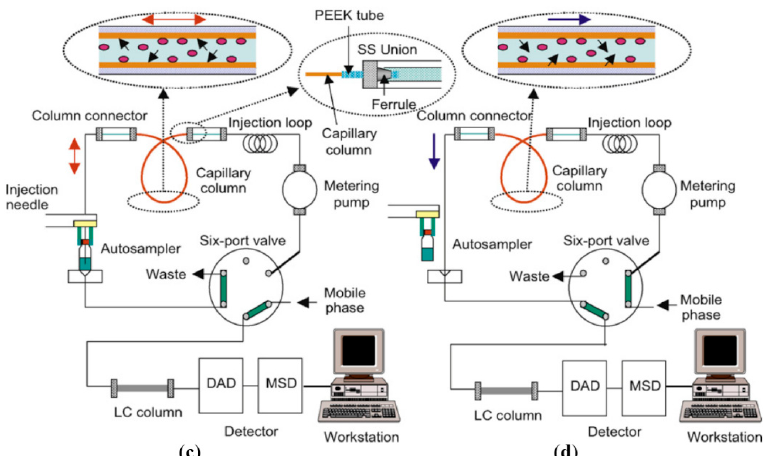
Figure 4. Schematic diagram illustrating the automated on-line in-tube SPME/HPLC technique. Flow-through extraction system ( a ) load position (extraction) and ( b ) inject position (desorption); and draw/eject extraction system ( c ) load position (extraction) and ( d ) inject position (desorption). Adapted from Reference [5]. Reprinted by permission from Elsevier.